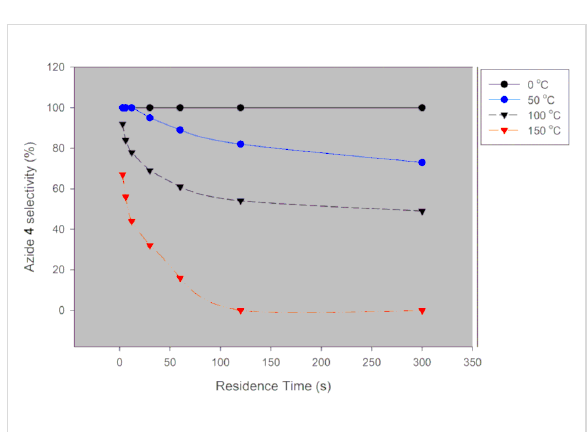
Figure 5: Effect of NaN 3 concentration on mesyl shikimate 4 conver- sion and azide 5 selectivity.